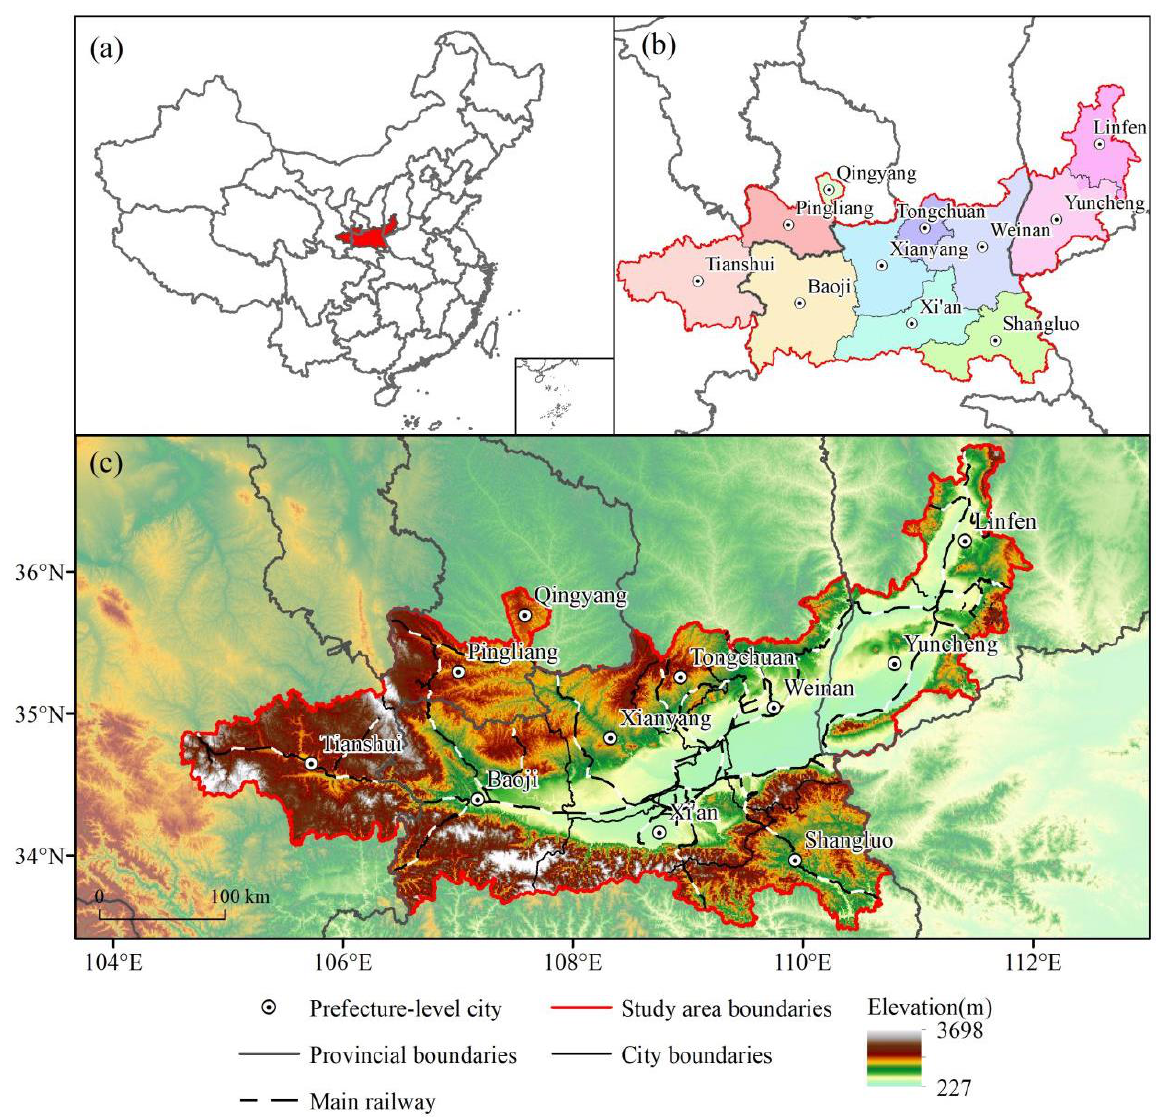
Figure 2. Overview of Guanzhong Plain urban agglomeration: ( a ) location in China; ( b ) administra- tive divisions; ( c ) elevation.